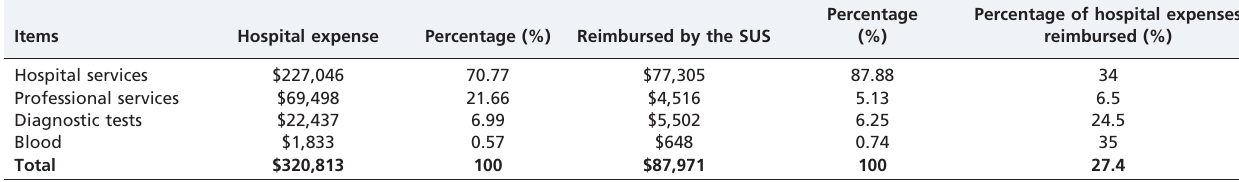
Table 7 - A comparison between the composition of estimated hospital expenses and the amount reimbursed by